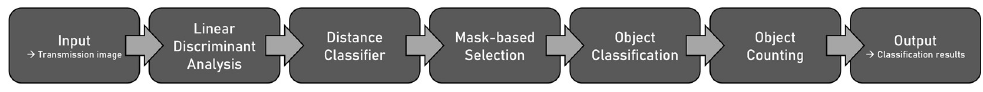
Figure 4. General structure of multivariate data processing and spectral model.